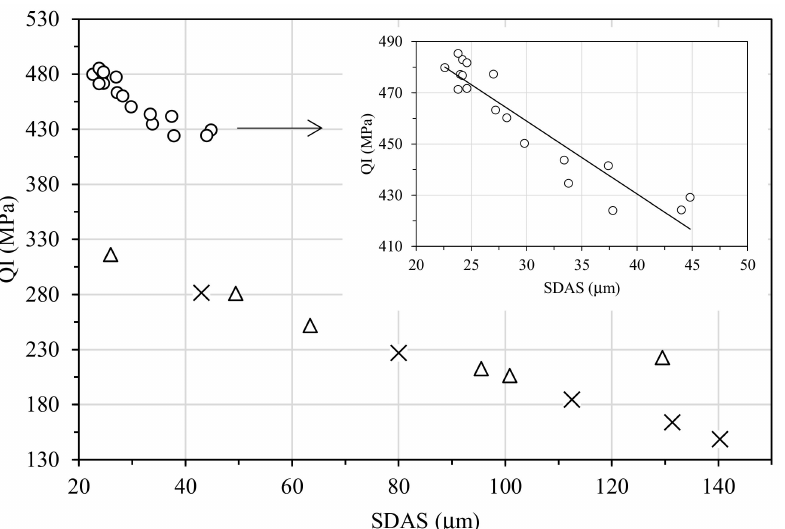
Figure 10. Evolution of experimental SDAS with QI in castings SK-1 to SK-6 (open circles), and in series A (crosses) and series C (open triangles) from Khomamizadeh et al. [25]. The small graph inside shows an extended view of data obtained in the present work with the best linear least square fit of these